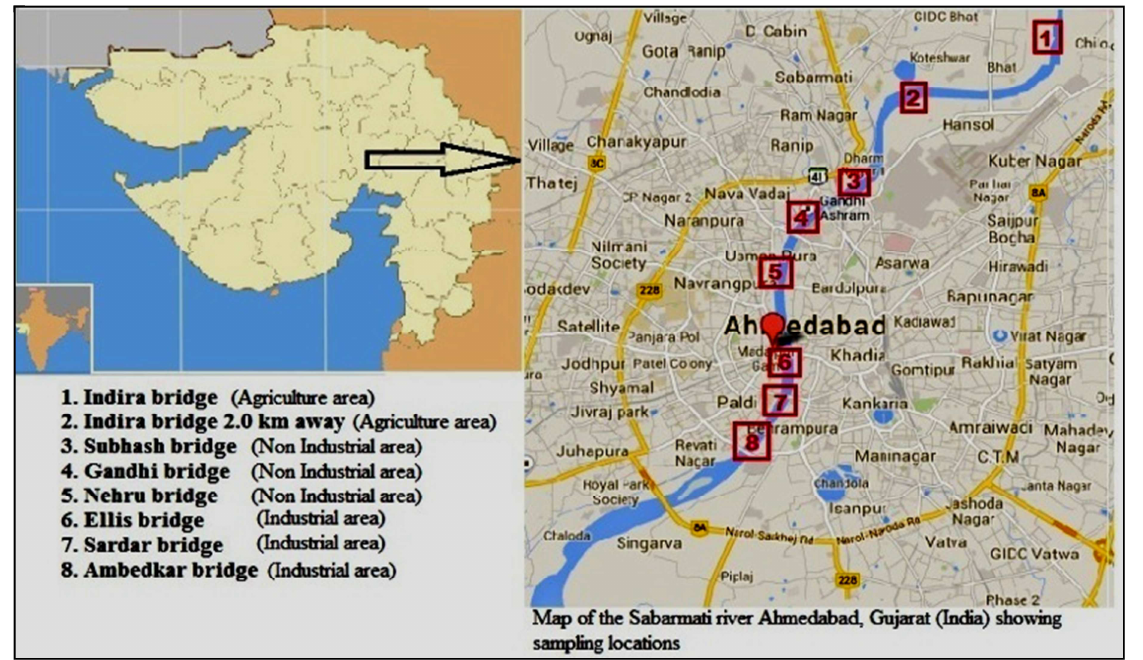
Figure 1. Map of the Sabarmati River Ahmedabad,